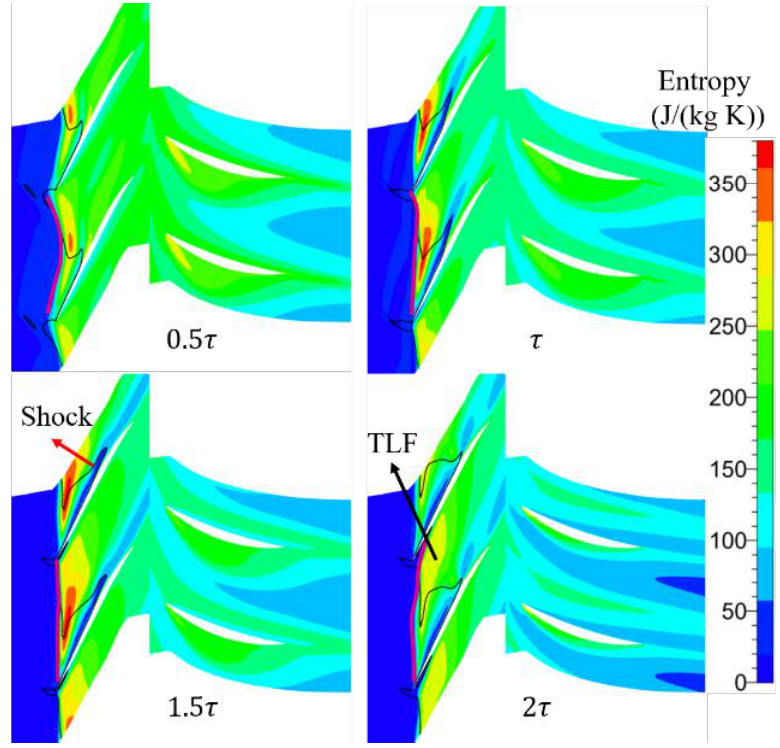
Figure 17. Entropy contours at 98% blade span for different rotor tip clearances at the NSP.